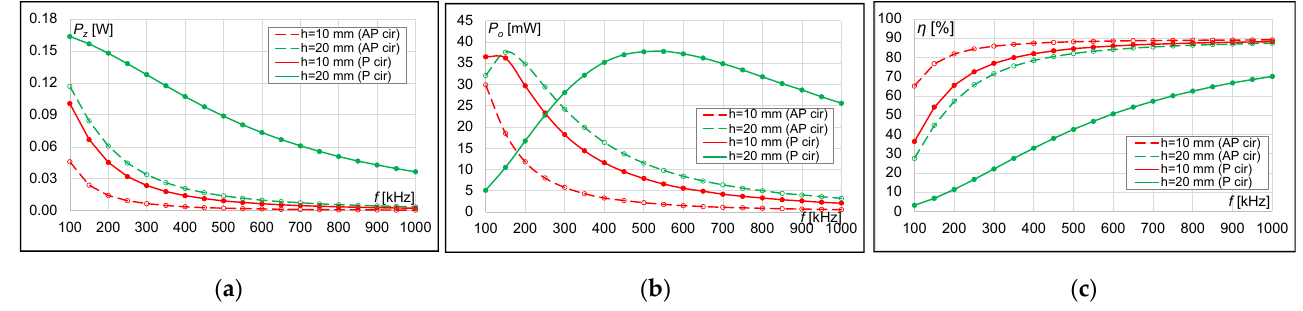
Figure 11. Results for circular coils with r = 20 mm and the number of turns n = 60 at two distances ( h = 10 mm and h = 20 mm): ( a ) transmitter power, ( b ) receiver power, ( c ) power transfer efficiency.